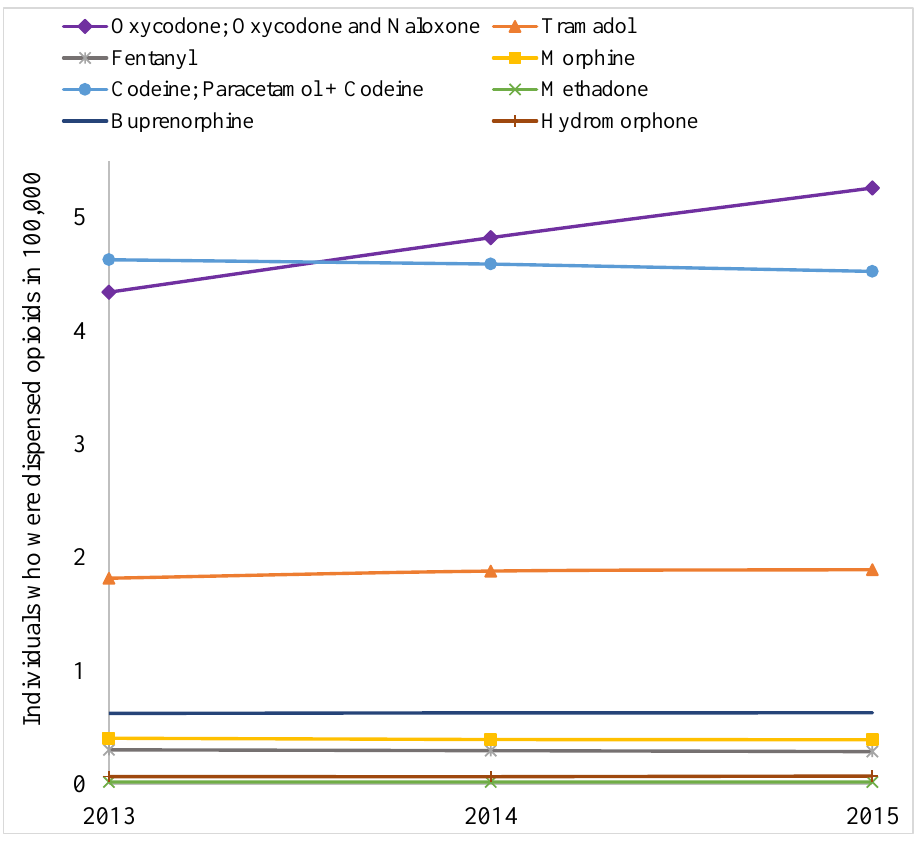
Figure 2. Items dispensed to individuals during the study period. Table 1. Quantity of major opioids dispensed under Pharmaceutical Benefits Scheme (PBS), Repatriation Pharmaceutical Benefits Scheme (RPBS), and under-copayment scheme (in DDD/1000 people/day).